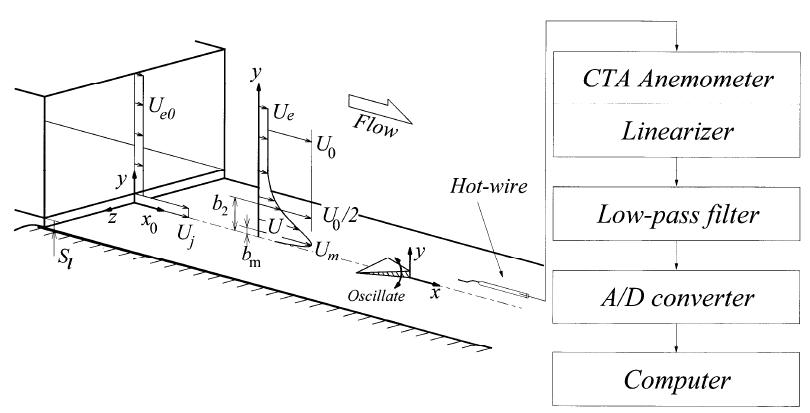
Fig.1 Schematic of flow field, nomenclature,